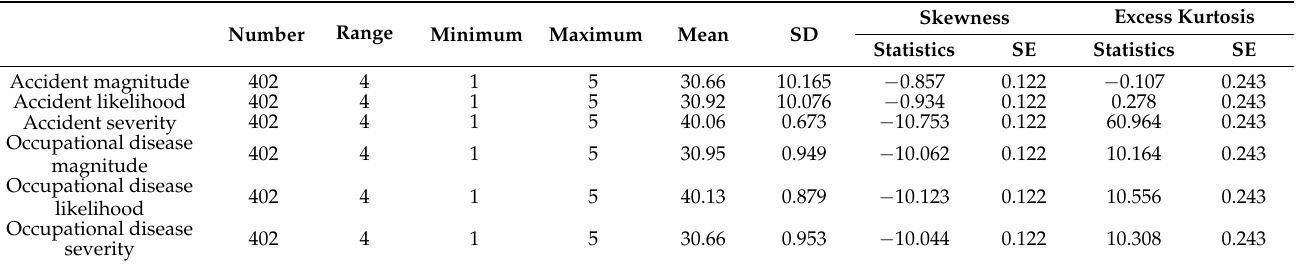
Table 5. Descriptive statistics of the risk